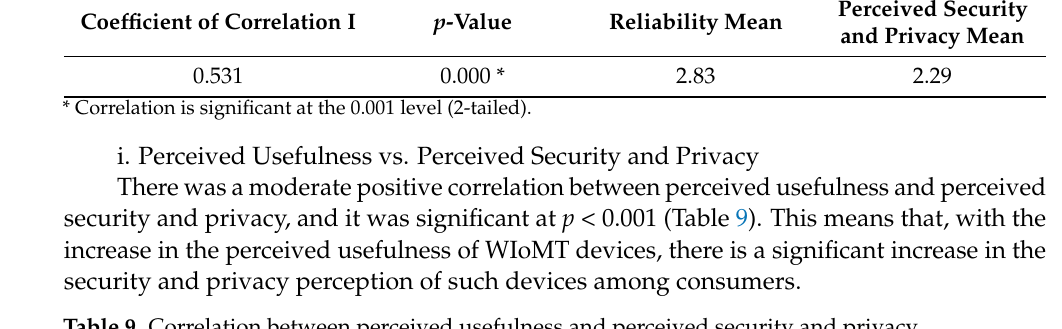
Table 9. Correlation between perceived usefulness and perceived security and privacy. Coefficient of Correlation I p -Value